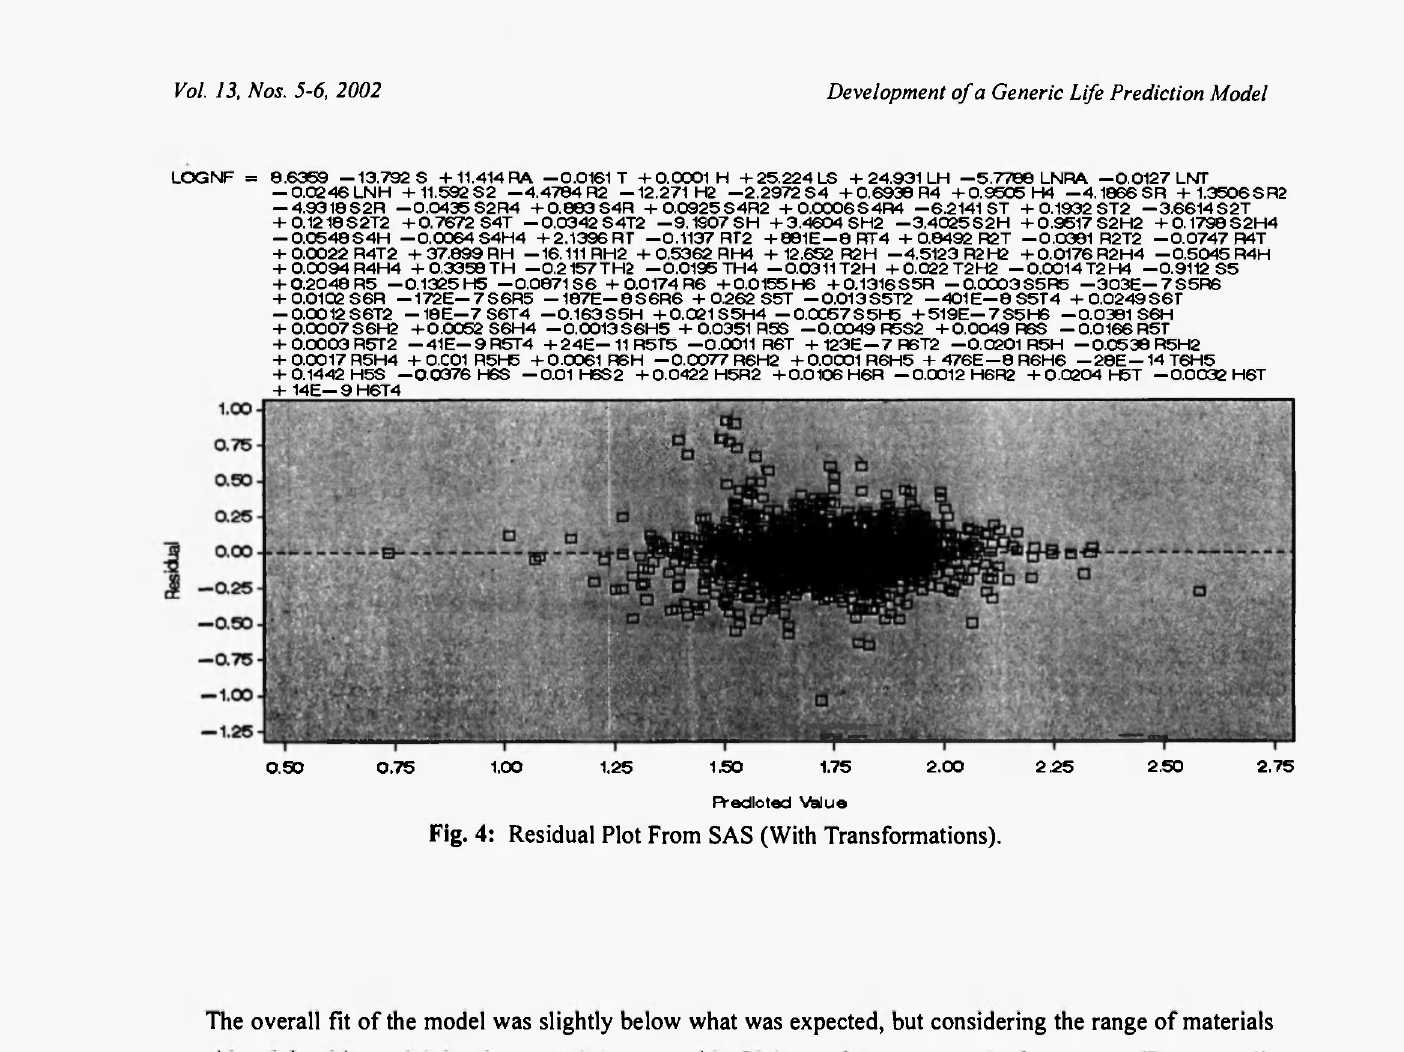
Fig. 4: Residual Plot From SAS (With